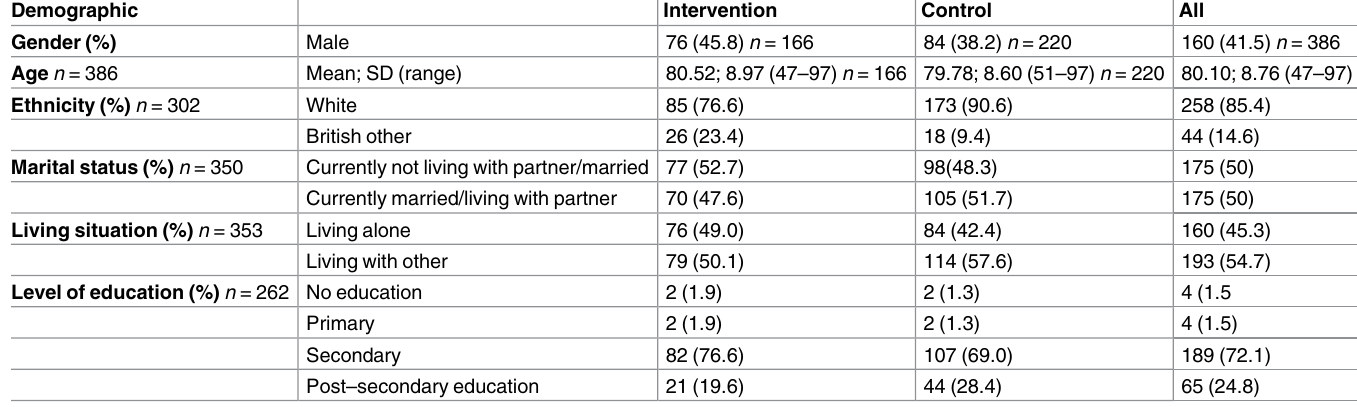
Table 1. Demographic characteristics of those presenting to memory clinics with suspected dementia.